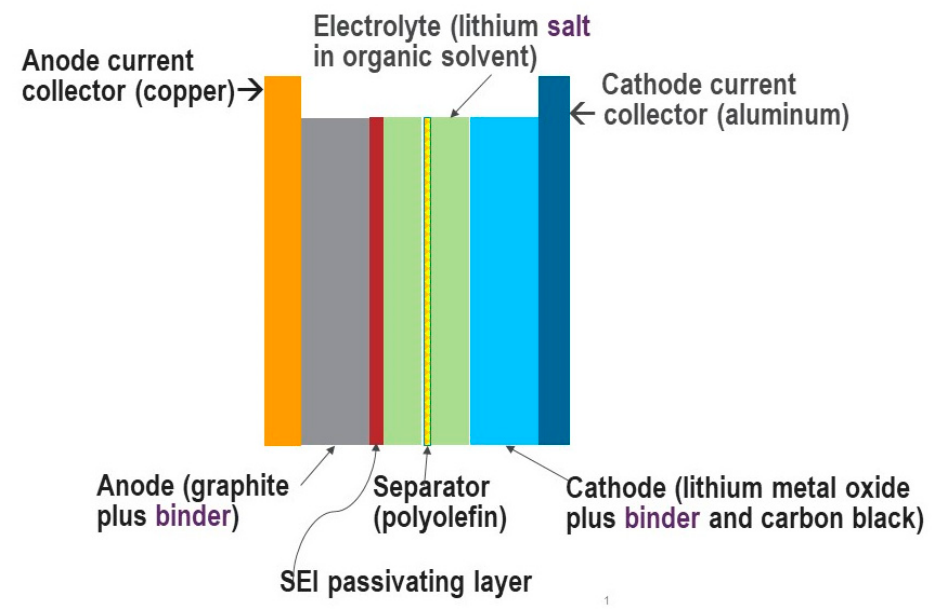
Figure 10. Cross-section of one layer of a lithium-ion cell.